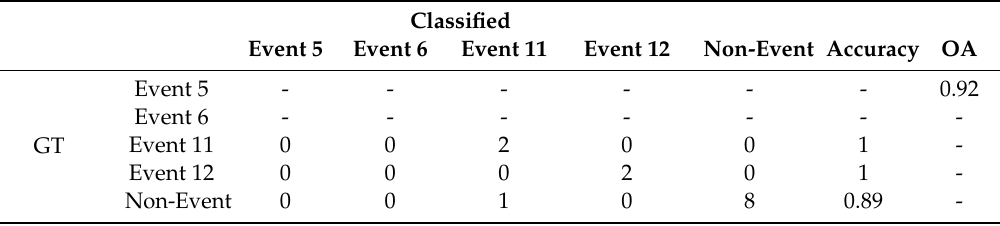
Event classification using the rule-based only approach for one VIRAT